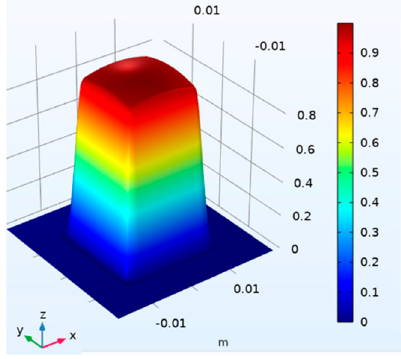
Figure 3. Top hat distribution function.